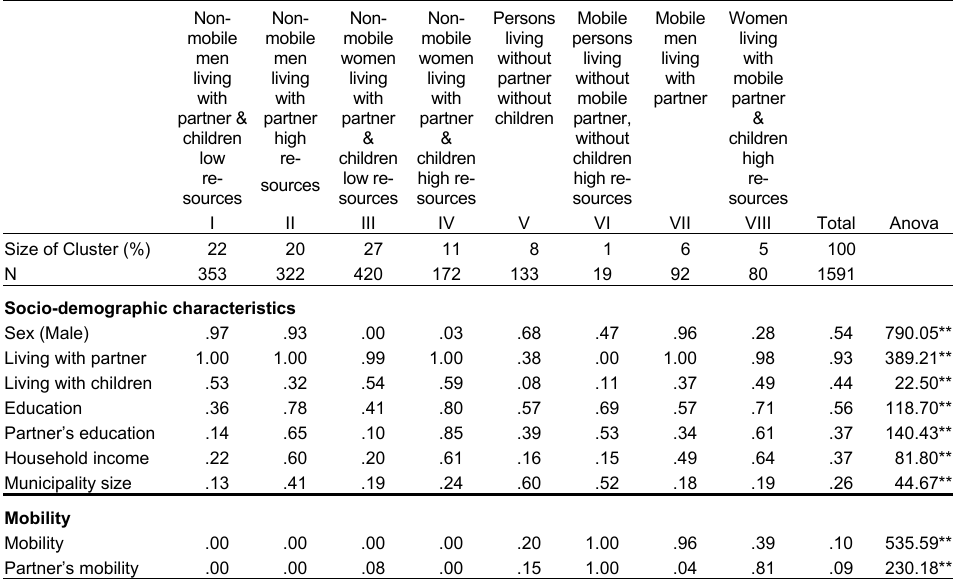
Table 2 : Types of positions in the social space